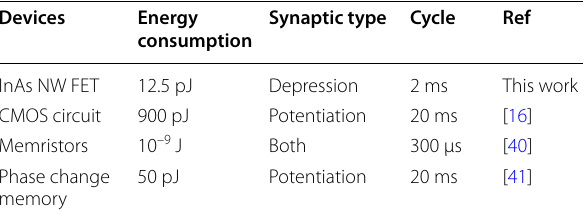
Table 2 Energy consumption of various synaptic devices